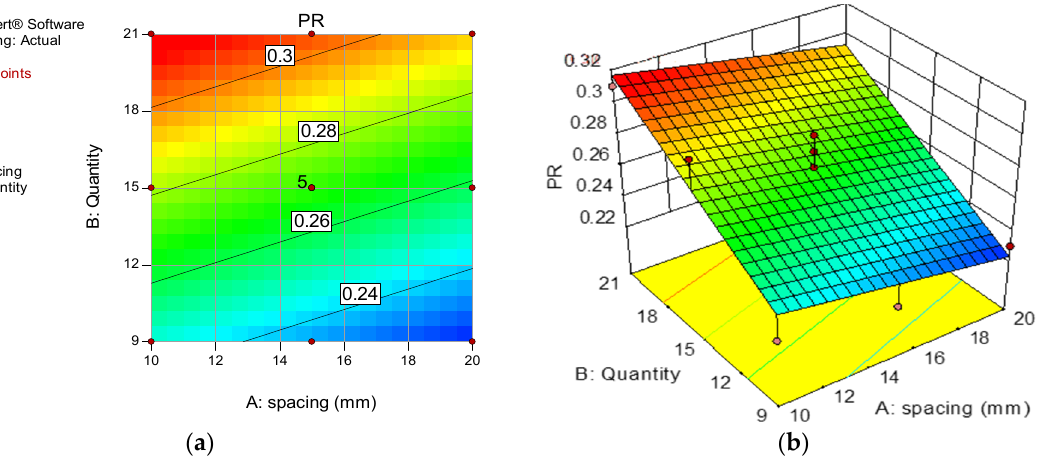
Figure 14. ( a ) Two ‐ dimensional contour plot; ( b ) Three ‐ dimensional response surface diagram for PR model.